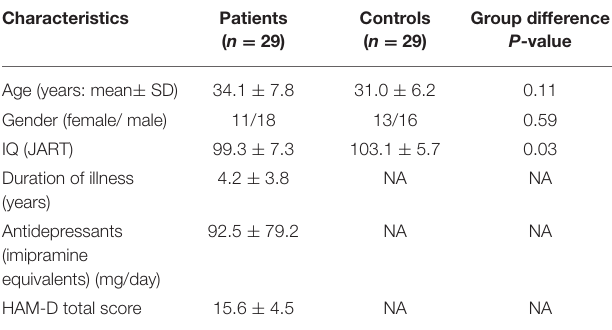
TABLE 1 | Subject